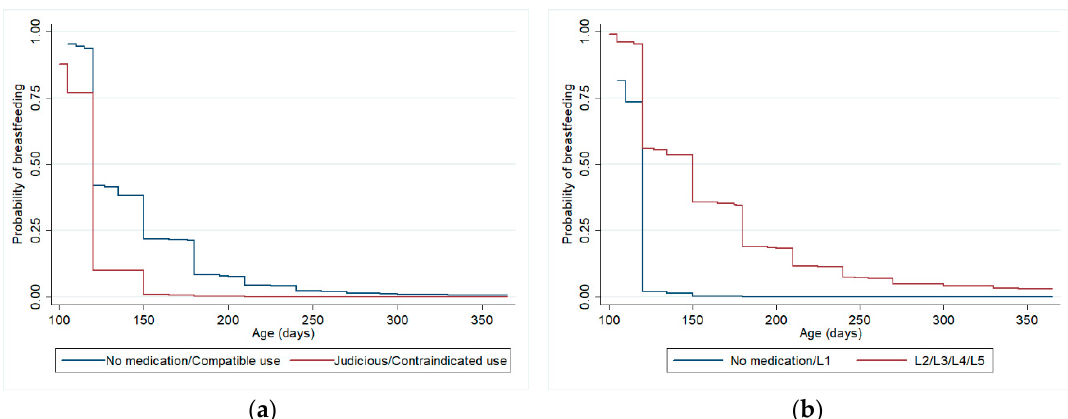
Figure 3. Kaplan-Meier curves (adjusted analysis *) for weaning from 3 to 12 months (excluding women who weaned before 3 months), according to maternal medication classified by Brazilian Ministry of Health Criteria ( a ) and Hale lactation risk categories ( b ). Pelotas (Brazil) Birth Cohort Study, 2015. * Analyses adjusted for maternal schooling, previous experience of breastfeeding and gestational age.